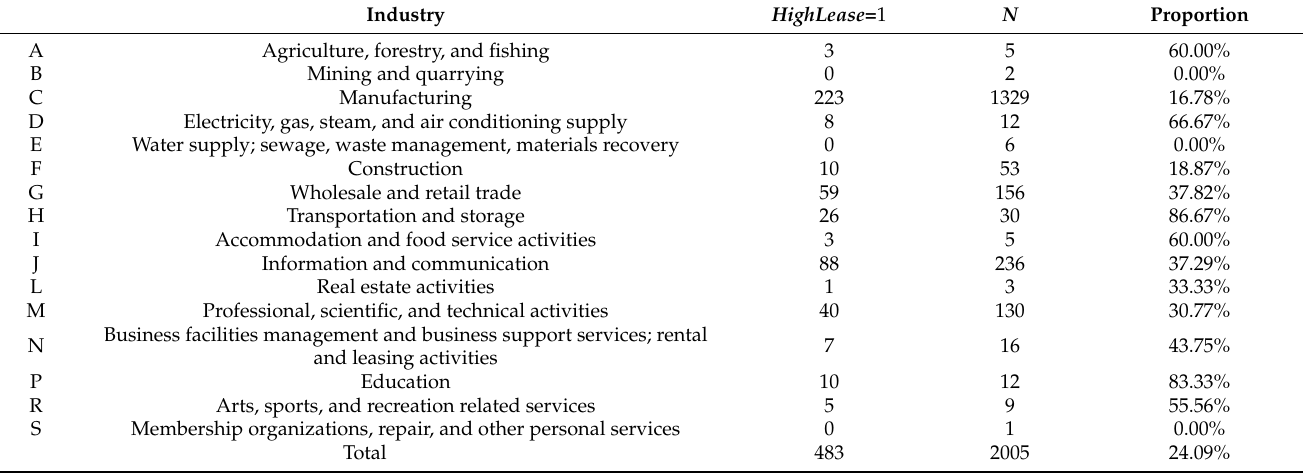
Table 3. Distribution of firms relied heavily on operating leases ( HighLease = 1) by industry in 2019. HighLease is a dummy variable that takes the value of 1 for firms in top 25 percentiles of the distribution of the difference between their 2019 lease liabilities and their 2018 lease liabilities relative to 2018 total assets, and 0 otherwise.